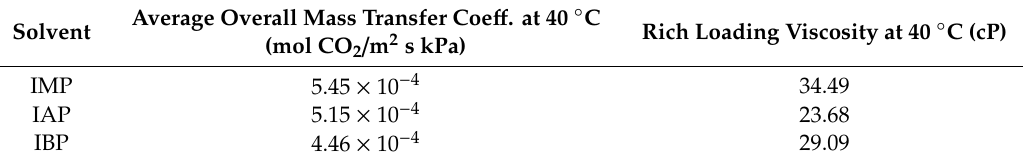
Table 3. Average overall mass transfer coe ffi cient and rich loading viscosity values of the investigated amine blends at 40 ◦